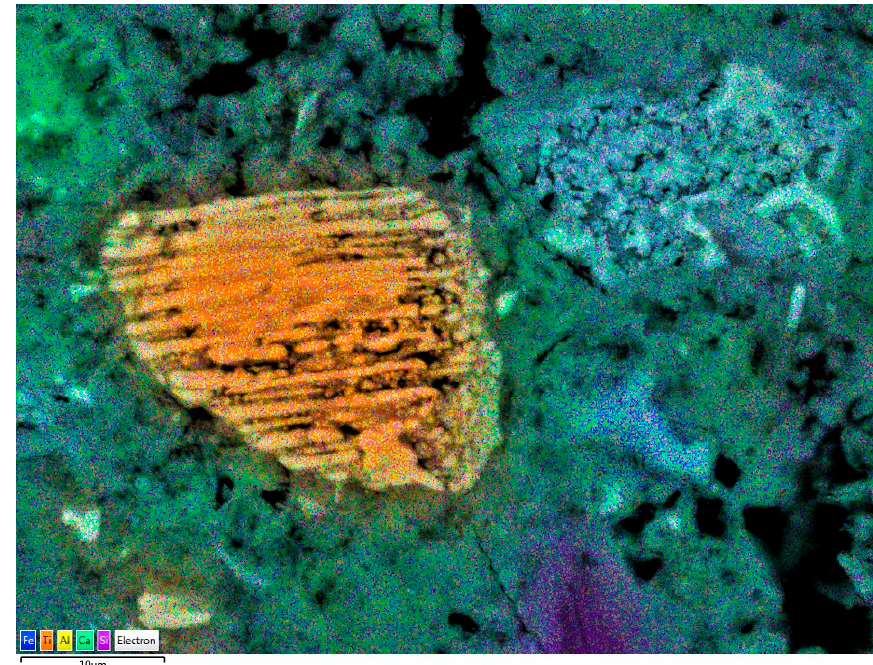
Figure 5. Energy dispersive X-ray spectroscopy (EDS) mapping of area presented in Figure 4.